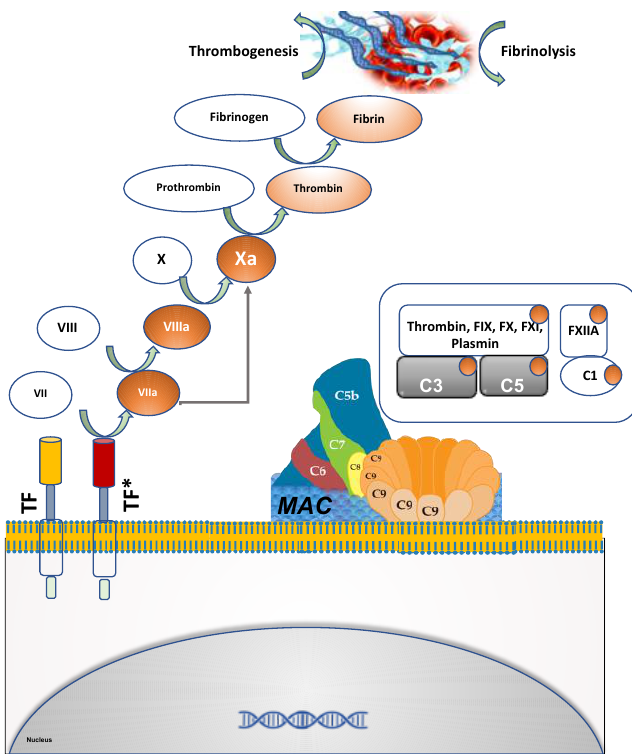
Figure 1. Extrinsic coagulation cascade is characterized by sequential activation and amplification of downstream components that finally culminate into the generation of the fibrin clot. Tissue factor (TF) is the primary trigger of the coagulation cascade. It is activated in the damaged endothelial cells. Platelets, polymorphonuclear cells and red blood cells (RBCs) entangled in the fibrin mesh result in clot expansion. Several components of the extrinsic coagulation cascade activate the complement system, as shown in the box.